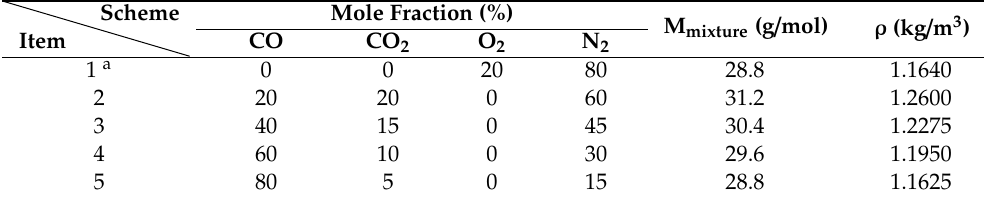
Table 3. The compositions of the ambient